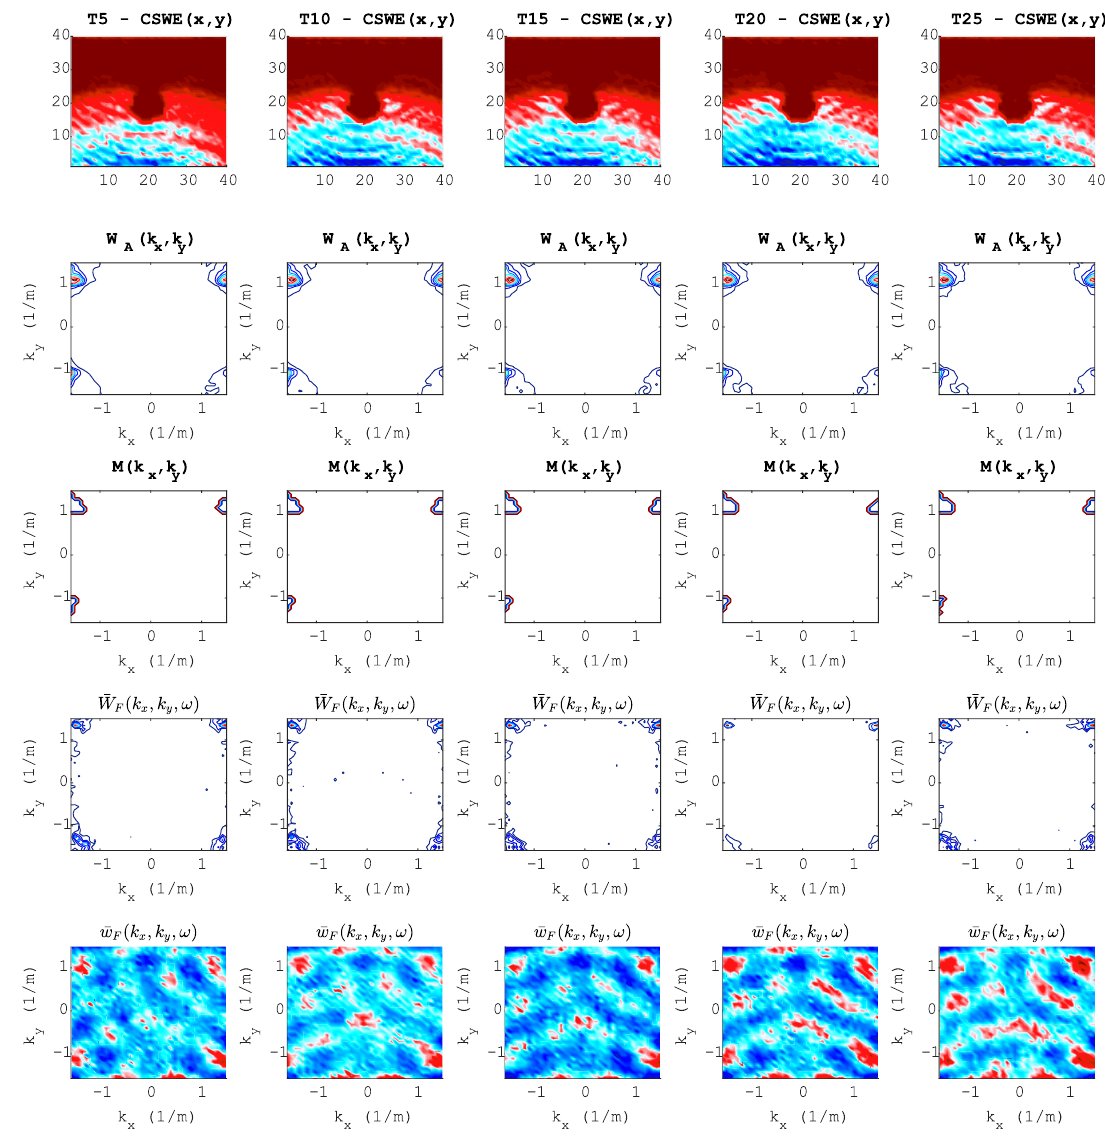
Figure 16. Preprocessing pipeline: Each column represents each torque value (T). Each row represents each processing step at t = 37 µ s. Row 1, wavefield image of a standing wave; Row 2, averaged wavefield image in the wavenumber domain; Row 3, adaptive filter mask; Row 4, filtered wavefield image in the wavenumber domain; Row 5, wavefield image in space domain after adaptive